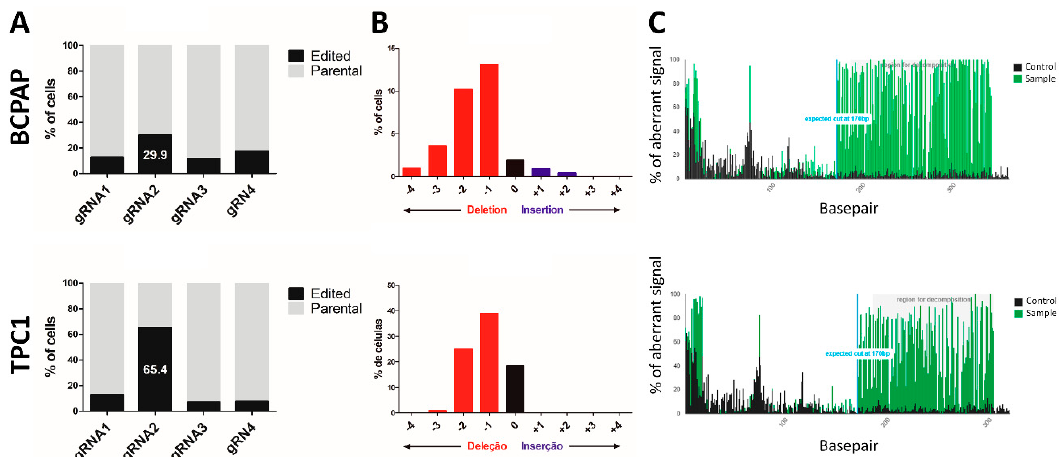
Figure 2. CRISPR/Cas9 introduced frameshift insertion/deletion (indel) mutations of LIMD2. ( A ) tracking of indels by decomposition (TIDE) decomposition algorithm analysis showing high editing efficiency of four different gRNAs. The gRNA2 exhibited the highest editing efficiency rate for BCPAP (29.9%) and TPC1 (65.4%) cells; ( B ) The indel spectrum within ±4 bp from predicted gRN2A cleavage site. The majority of edited cells presented deletion of a single nucleotide; ( C ) TIDE decomposition analysis showing the detection of mixed peaks in the Sanger sequence reads. The aberrant signal in non-edited (black) and edited cells (green) and the expected cleavage site at 170 bp (blue line).